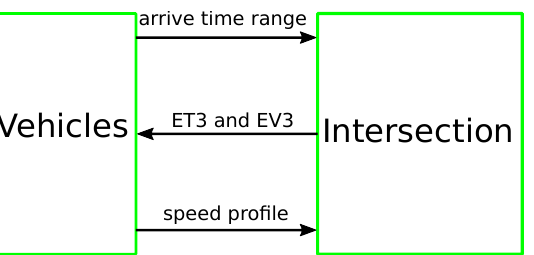
Figure 5. Flowchart of communication process between vehicles and